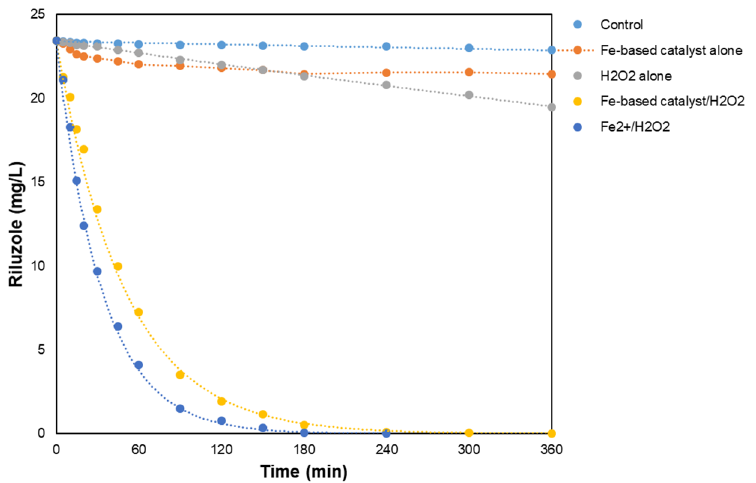
Figure 3. Changes of riluzole concentration with time during the treatment of 23.4 mg/L riluzole aqueous solutions using a Fe-based catalyst/H 2 O 2 system (exponential trend lines are added dashed lines). Experimental conditions: H 2 O 2 : 1000 mg/L, Fe-based catalyst: 200 mg/L (particle size < 200 µm), Fe 2+ : 140 mg/L, pH = 3.0, Temperature: 23–25 °C, Mixing rate: 400 rpm.